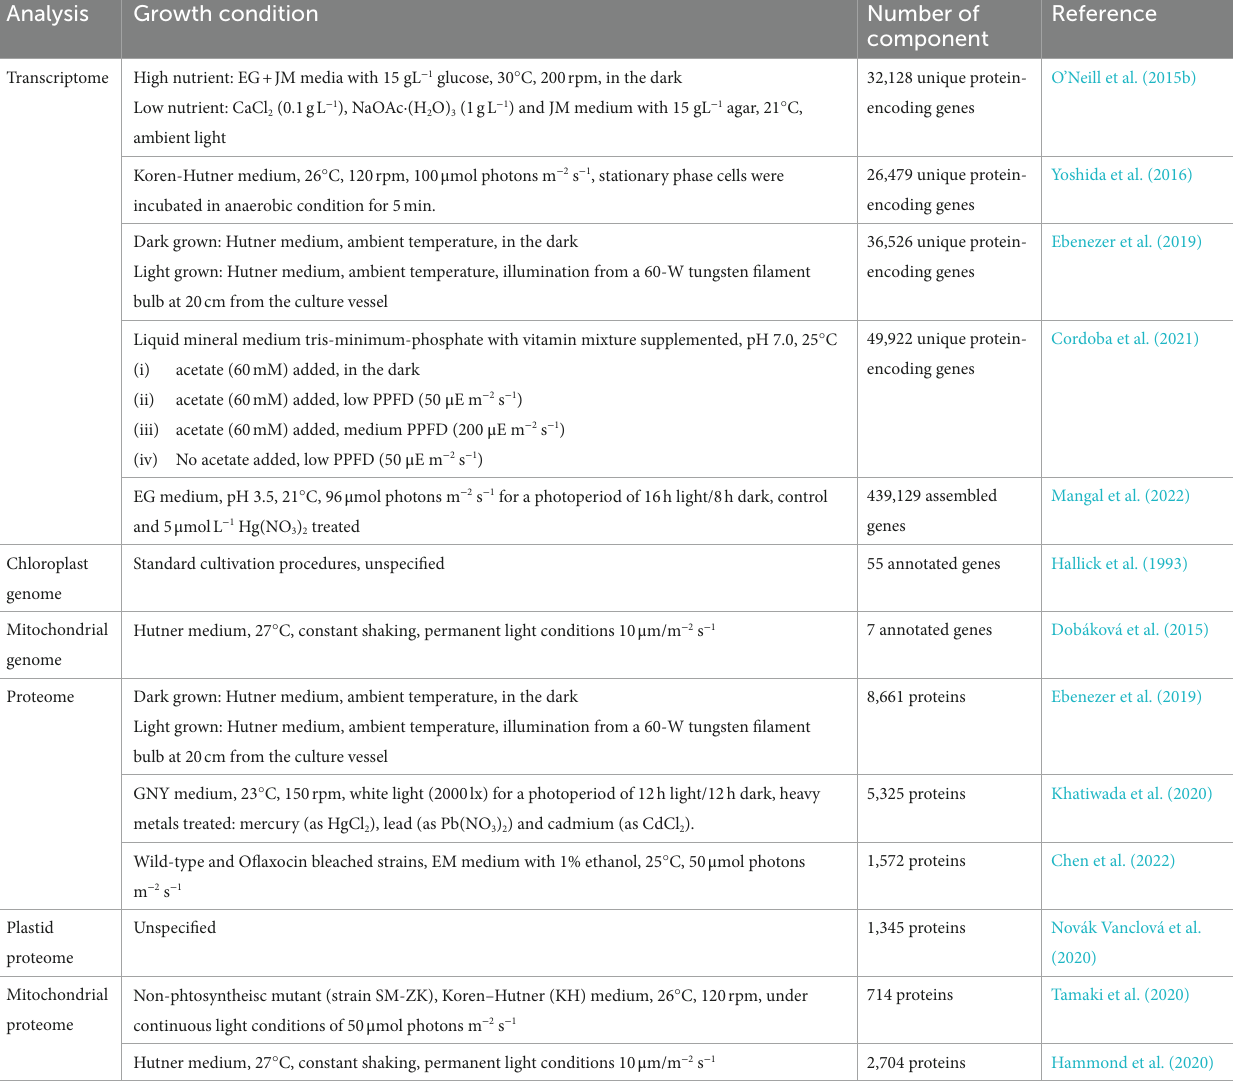
TABLE 1 Published transcriptome, organelle genome and proteome data of E. gracilis. Analysis Growth condition Number of